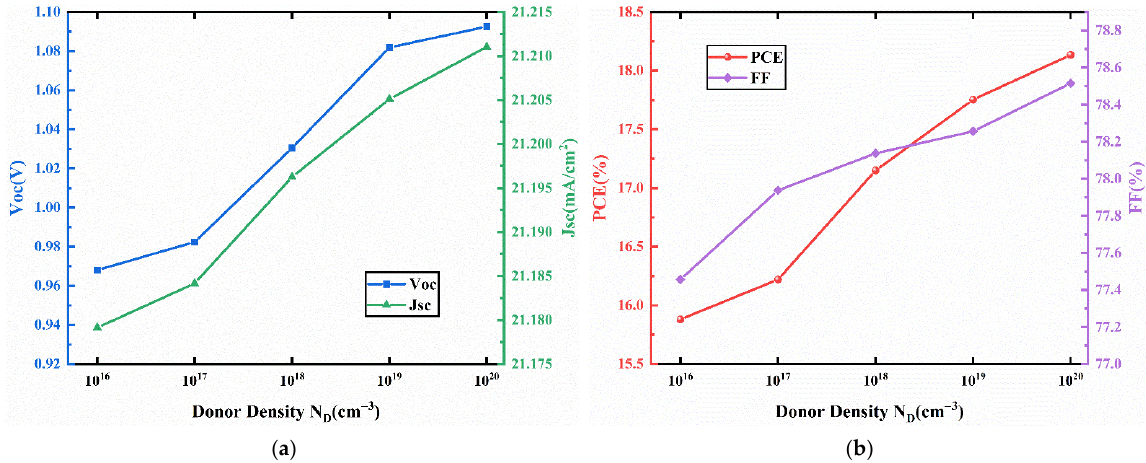
Figure 10. ( a ) Change in Voc and Jsc against ETL donor density (N D ) variation; ( b ) change in PCE and FF against ETL doping density (N D ) variation.